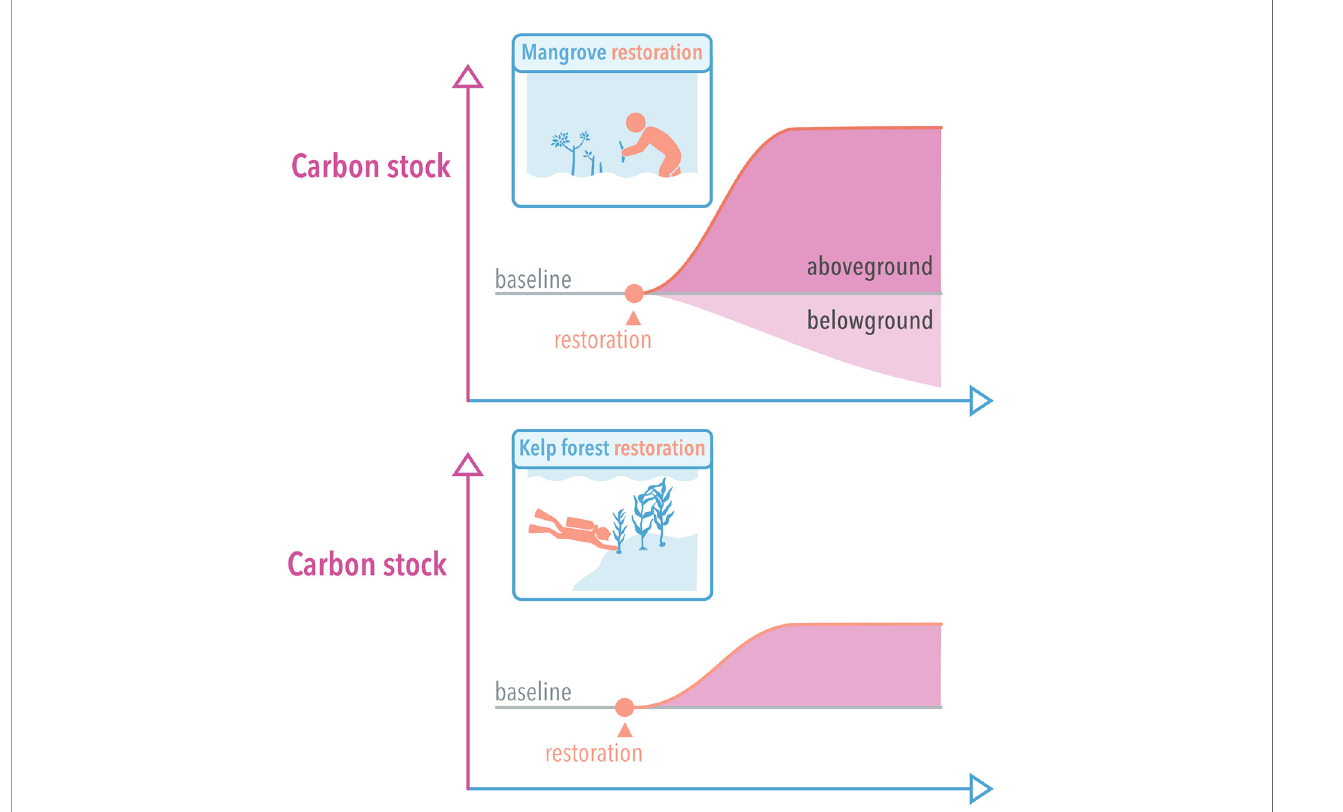
FIGURE 3 | Schematic representation of carbon stock changes for two distinct types of ecosystem (mangrove and kelp) in the context of restoration. The pink shaded area is the carbon that could be attributed to the project activity. Adapted from Olander and Ebeling,